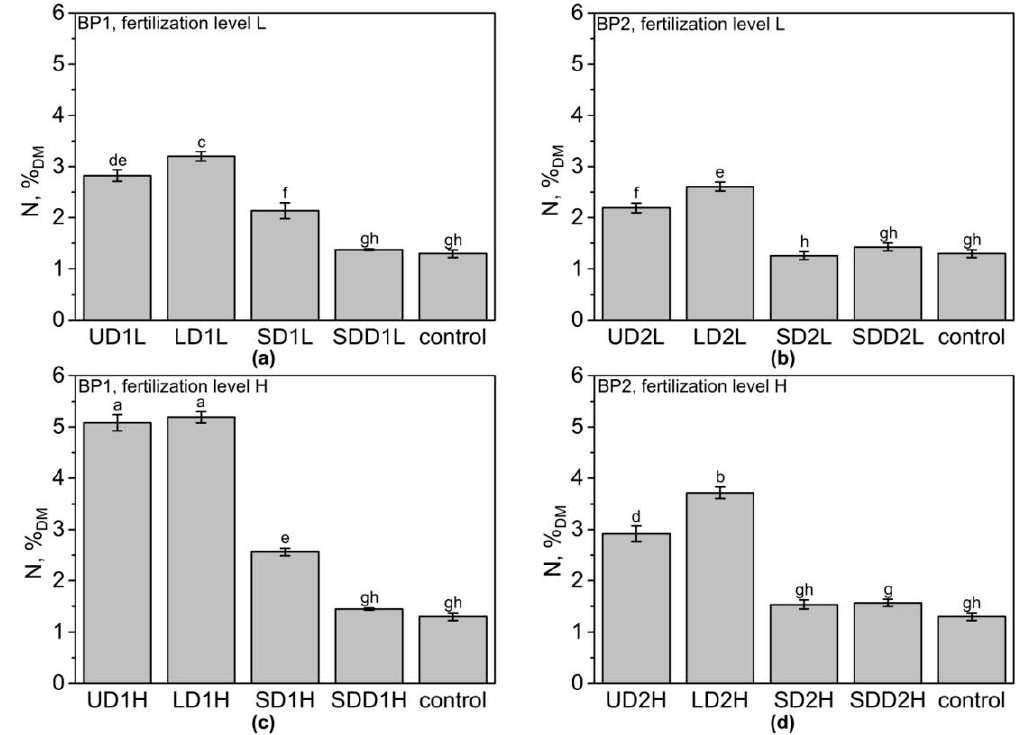
Figure 3. Nitrogen content %N of above-ground biomass for different treatments: ( a ) Treatments based on manure as feedstock from BP1 with fertilization level L; ( b ) Treatments based on energy crops as feedstock from BP2 with fertilization level L; ( c ) Treatments from BP1 with fertilization level H; ( d ) Treatments from BP2 with fertilization level H; (code see Table 1; n = 4, whiskers show standard deviation, different letters indicate significant differences, p = 0.05).